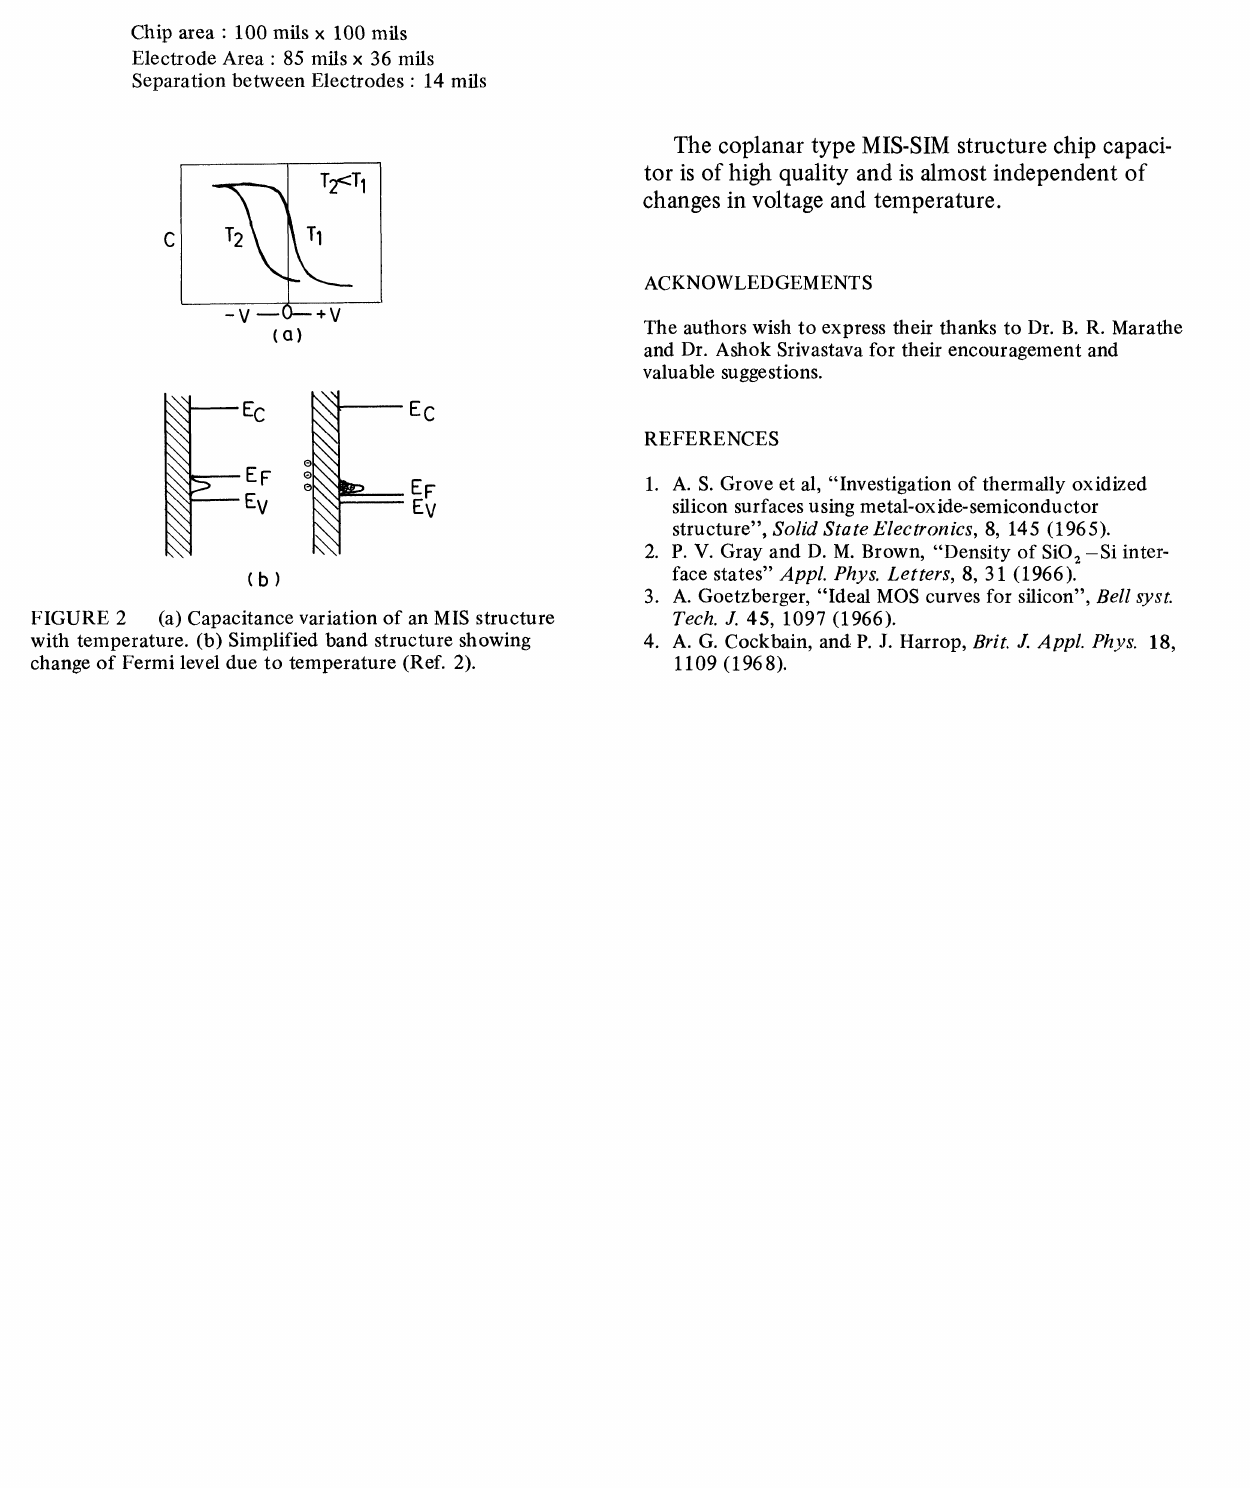
FIGURE 2 (a) Capacitance variation of an MIS structure with temperature. (b) Simplified band structure showing change of Fermi level due to temperature (Ref.